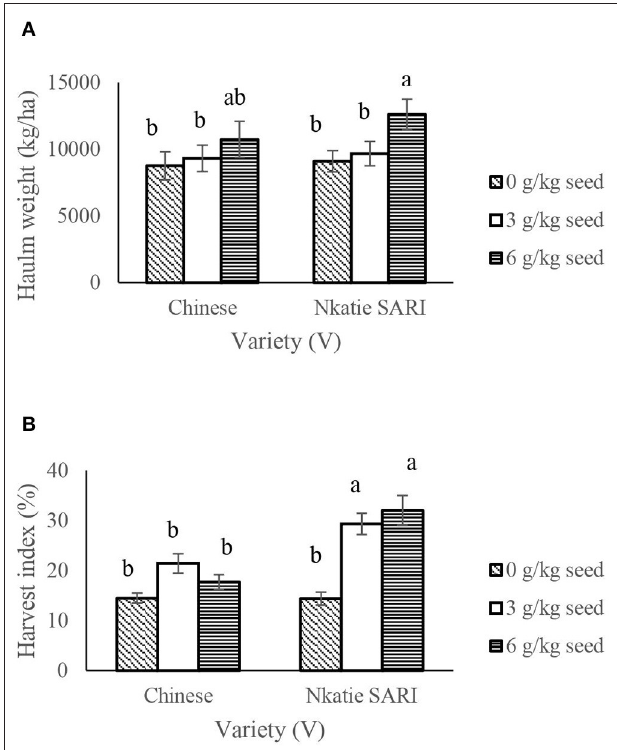
FIGURE 5 | Interactive effect of Innoculant rate (IR) and variety (V) on halum weight (A) and harvest index (B) of groundnut grown in Haplic Lixisols of northern Ghana. Bars with different letters (in horizontal direction) show significantly different means. Error bars represent standard error of